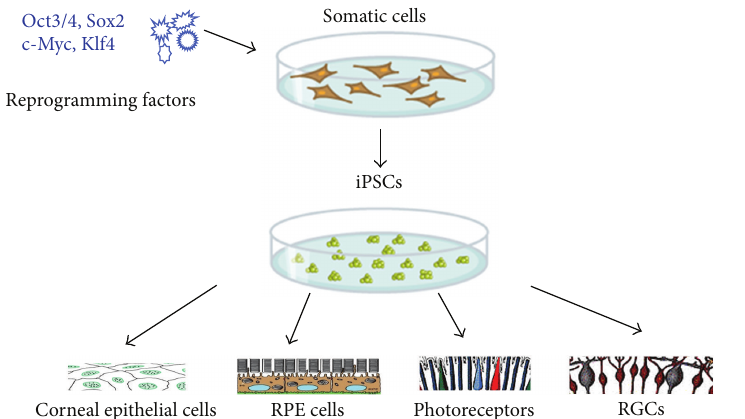
Figure 1: Schematic illustration of iPSC induction and reprogramming into ocular cells. iPS cells are generated by reprogramming adult somatic cells. In the ophthalmic field, iPSCs have been successfully differentiated into a variety of the ocular cells, including corneal epithelial cells, RPE, photoreceptors, and